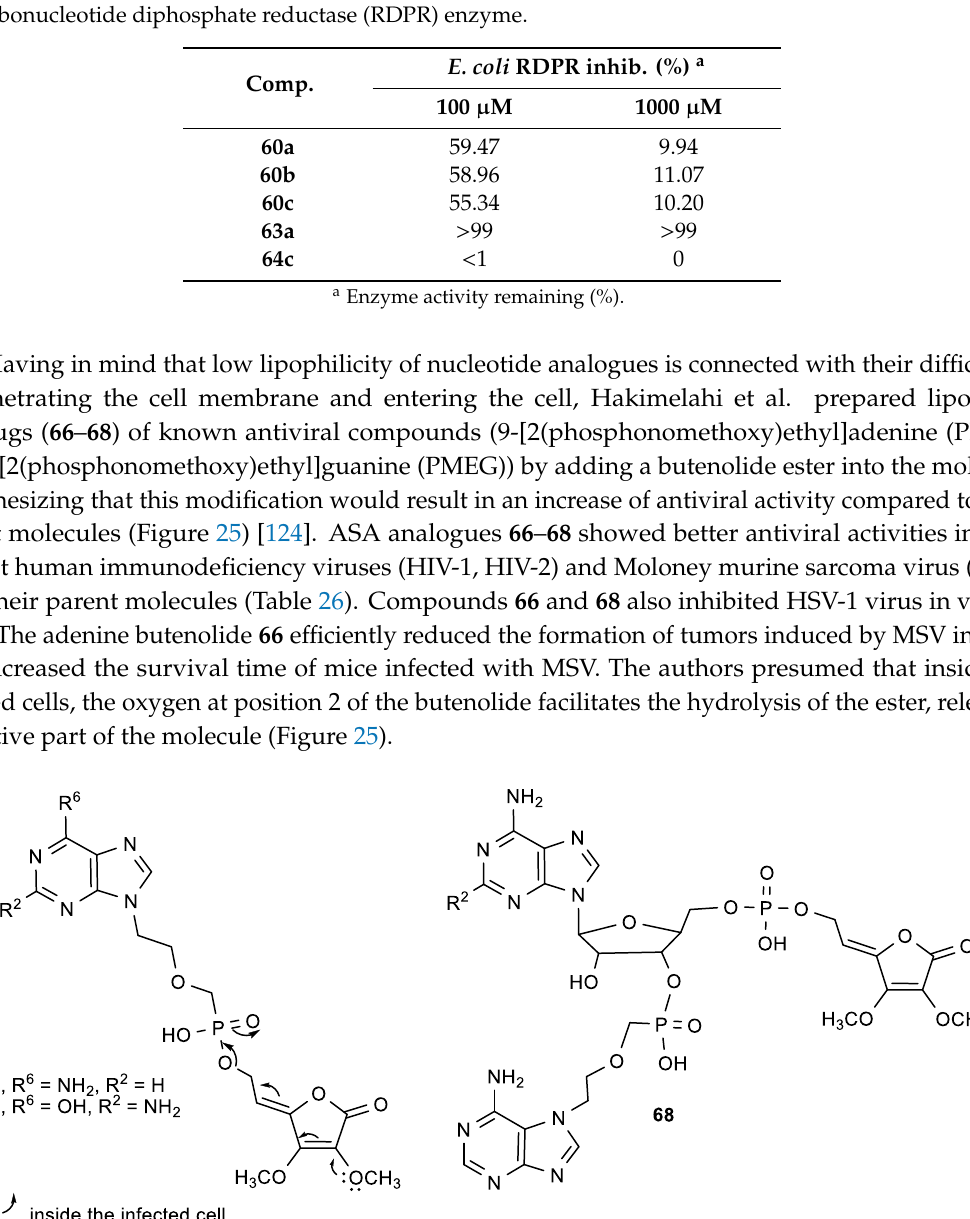
Figure 25. The butenolide derivatives of 9-[2(phosphonomethoxy)ethyl]adenine (PMEA) ( 66 ) and 9-[2(phosphonomethoxy)ethyl]guanine (PMEG) ( 67 ) and the nucleotide containing butenolide 68 . Table 26. The antiviral activities of lipophilic prodrugs 66 – 68 and their parent molecules. Comp.